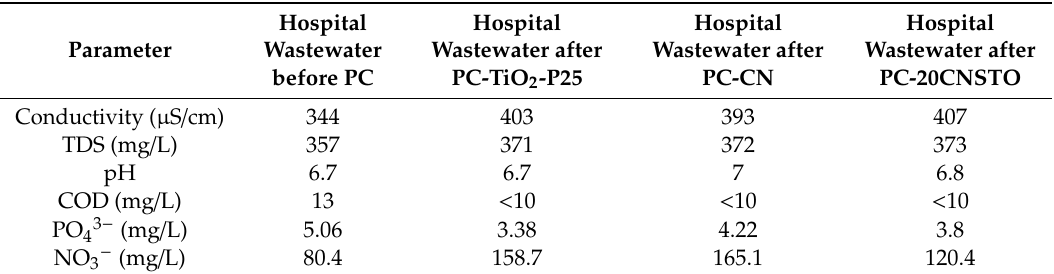
Table 5. Physicochemical characteristics of the hospital e ffl uent wastewater before and after the photocatalytic degradation in May. Hospital Parameter Wastewater before PC